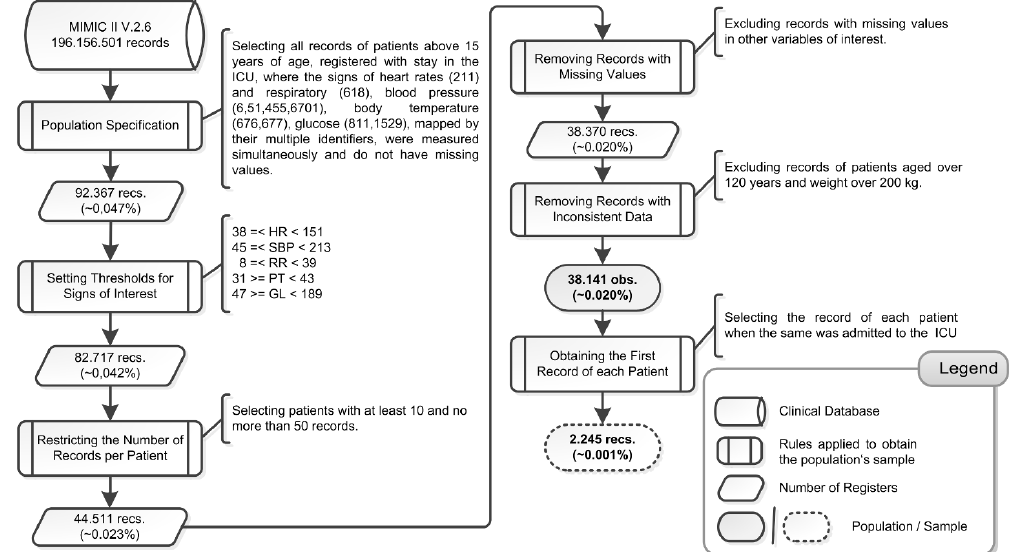
Figure 1. Process to Characterize the Population of Interest.